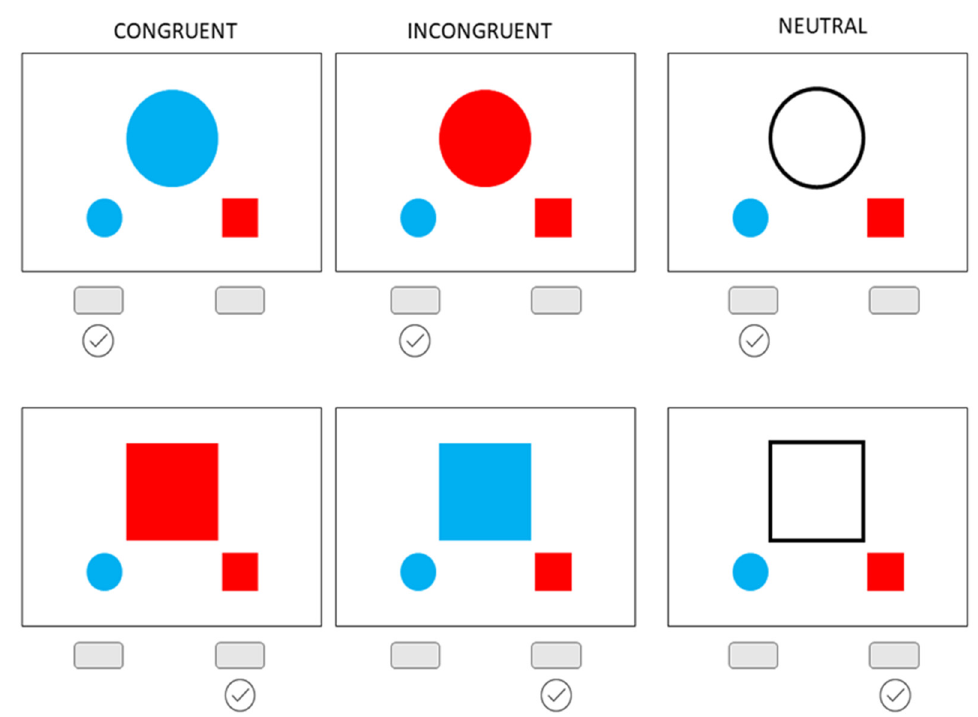
Figure 1. Bivalent Shape Task. Six stimuli were used in the task: the circle in blue color (congruent condition; correct response: left), red (incongruent condition, correct response: left), and no color (neutral condition; correct response: left), and the square in red color (congruent; correct response: right), blue (incongruent; correct response: right), and no color (neutral correct response: right).